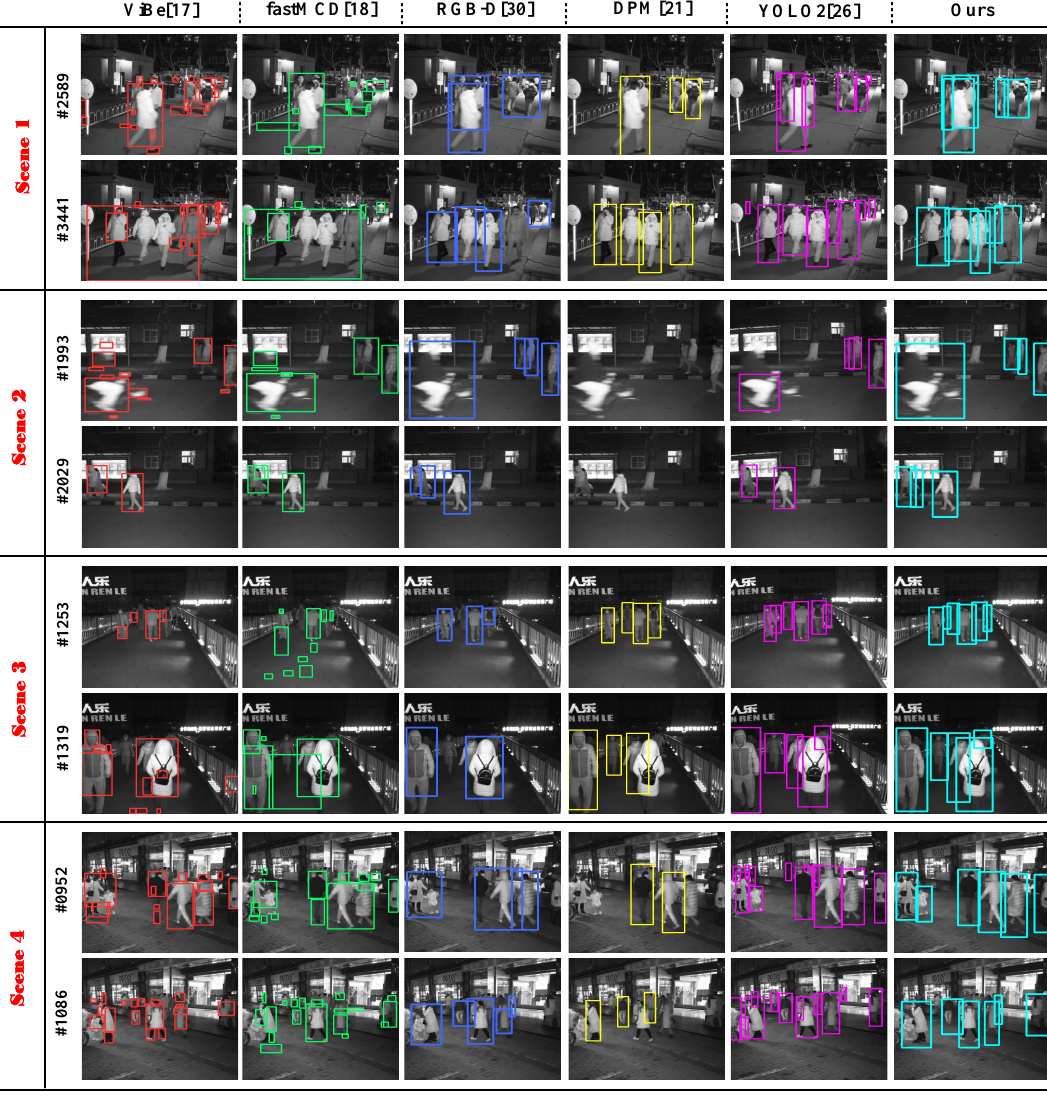
Figure 6. The detection results of four typical datasets showed the difference between our approach and the Visual Background extractor (ViBe) [17], the Deformable Parts Model (DPM) [21], fast MCD [18], You Only Look Once Version 2 (YOLO2) [26] and RGB-D [30]. The four scenarios include ( a ) school entrance; ( b ) footpath; ( c ) flyover and ( d ) busy street. Table 2. False alarm and missed rate of